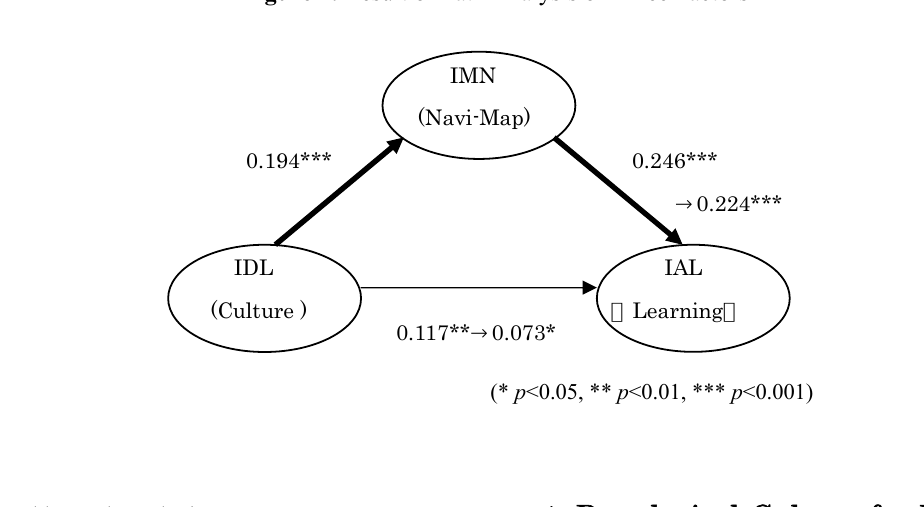
Figure 1. Result of Path Analysis of Three